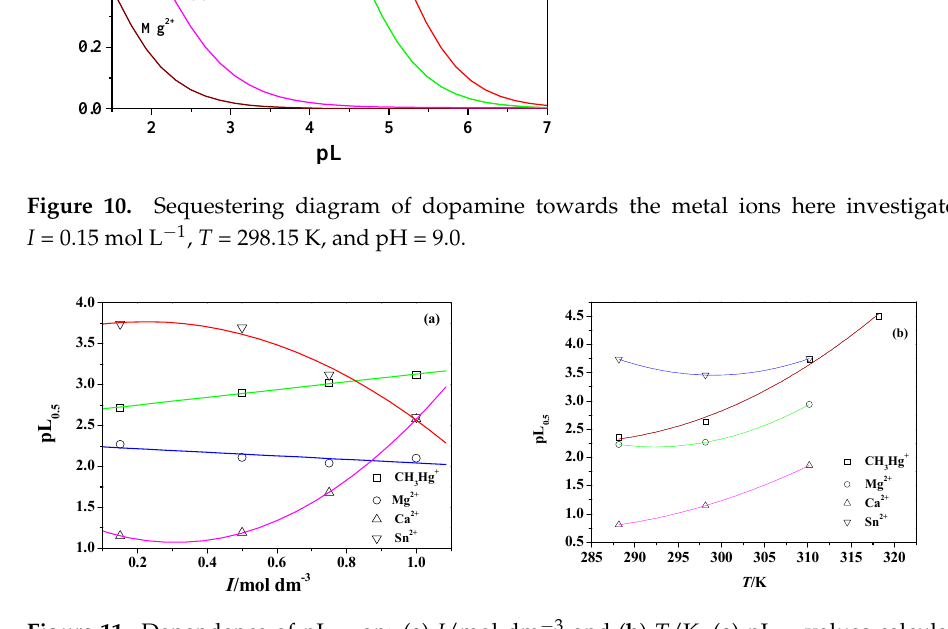
Figure 11. Dependence of pL 0 . 5 on: ( a ) I /mol dm −3 and ( b ) T /K. ( a ) pL 0 . 5 values calculated at T = 298.15 K, pH = 7.4 and different ionic strengths; ( b ) pL 0 . 5 values calculated at I = 0.15 mol dm −3 , pH = 7.4 and different temperatures. Table 12. Sequestering ability of dopamine towards metal ions at T = 298.15 K, pH = 7.4 and different ionic